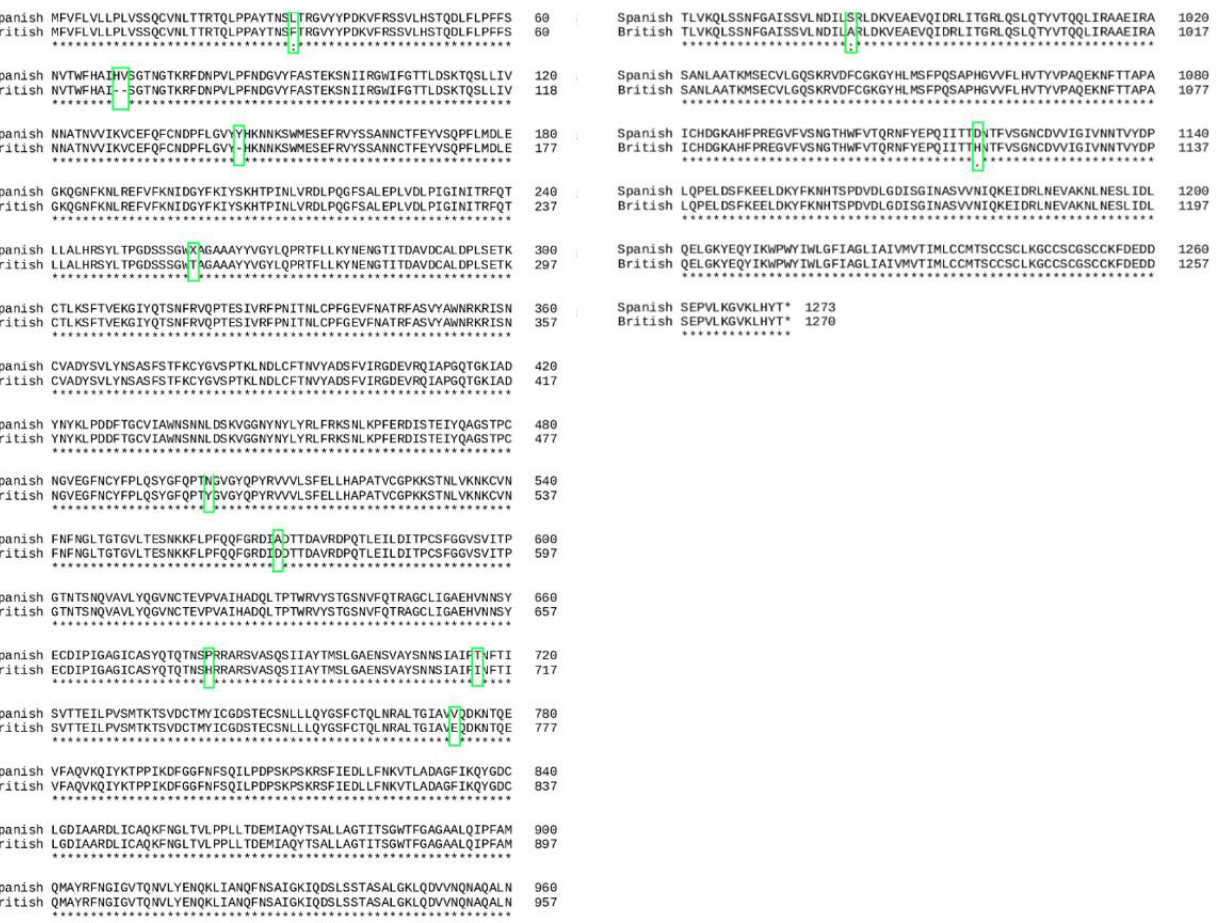
Figure 2. Translation of the spike gen into amino acid sequence in the two variants. A consensus line is shown below the amino acid alignment of the two variants, with the following symbols indicating the degree of conservation observed for each compared pair: “*” (identical residues in all sequences), “:” (highly preserved column), “.” (weakly preserved column). One-letter notation of amino acid sequence used from reference [13].